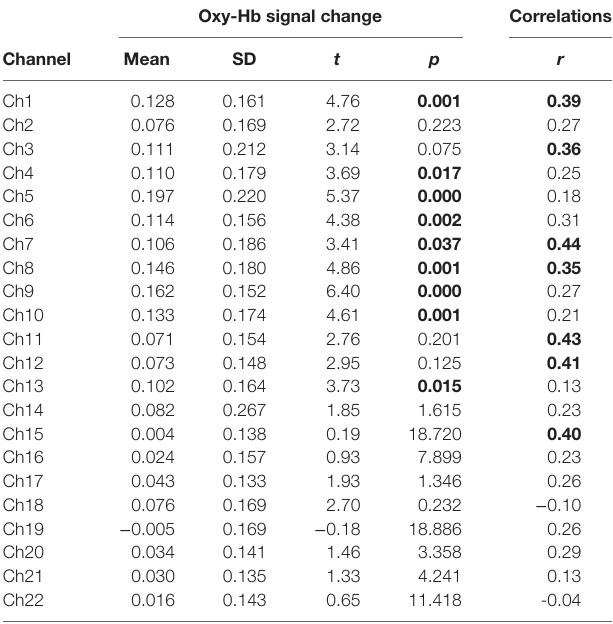
Table 3 | Functional data summary for all subjects and correlations between oxy-Hb signal change and salivary OT levels. Oxy-hb signal change